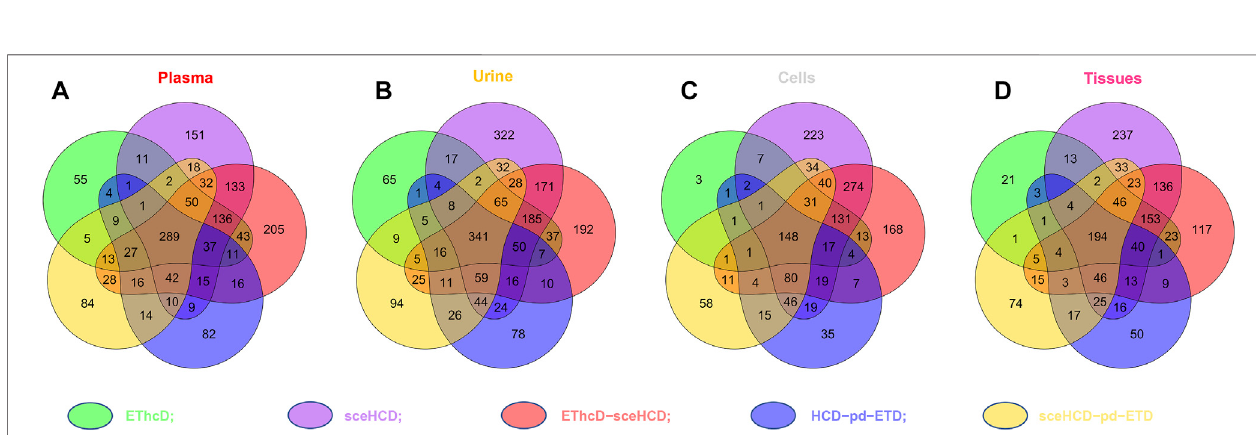
Frontiers in Chemistry |